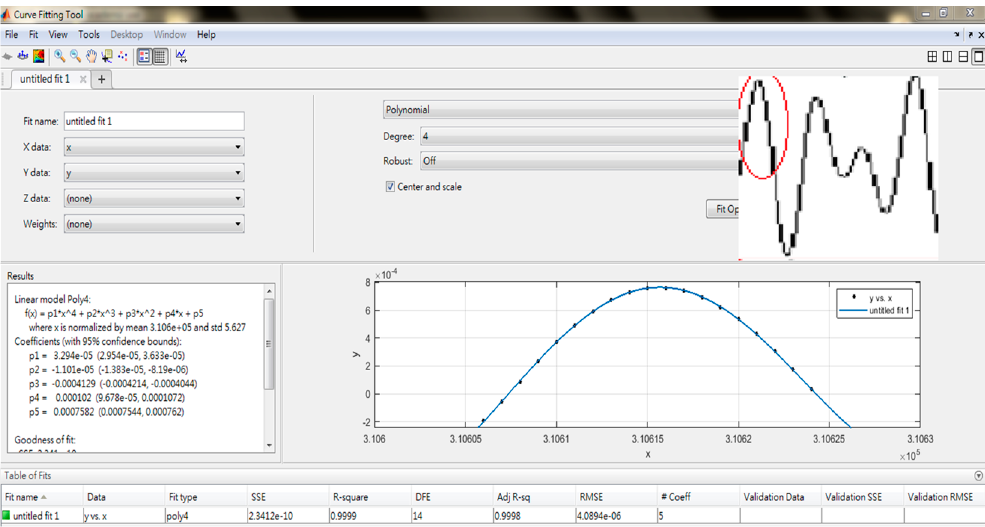
Figure 11. Utilizing a curve fitting method to find the peak time from the processed signal to increase the time resolution for range finding.